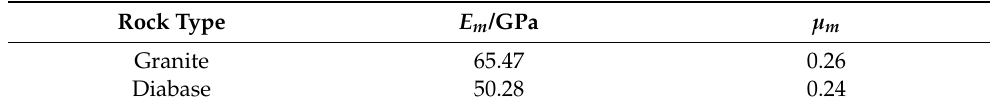
Table 1. Average values of Young’s modulus and Poisson’s ratio for Beishan granite [26] and Danjiangkou diabase